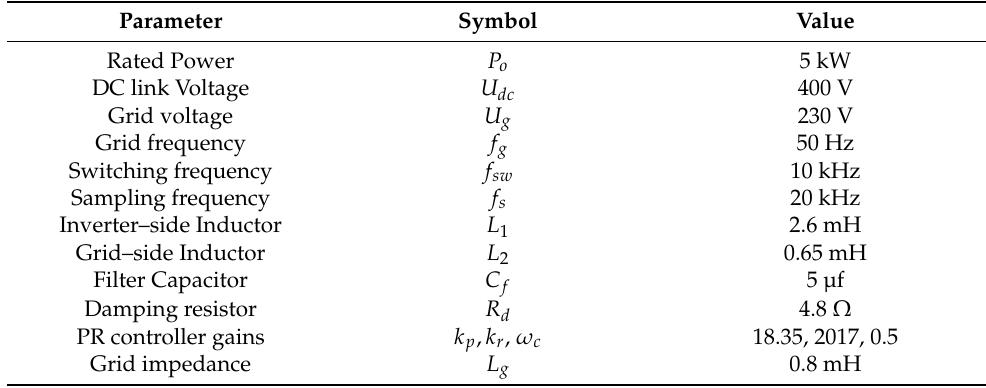
Table 1. Rated data, LCL filter parameters, PR current controller gains of the identical grid–connected VSI and the grid impedance